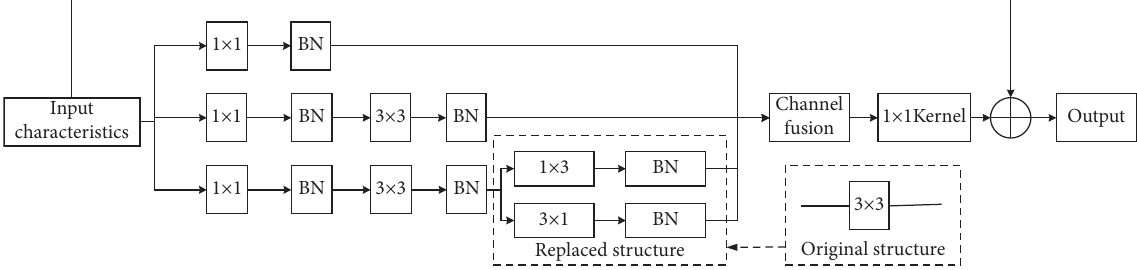
Figure 4: Optimized Inception-v2 module structure.